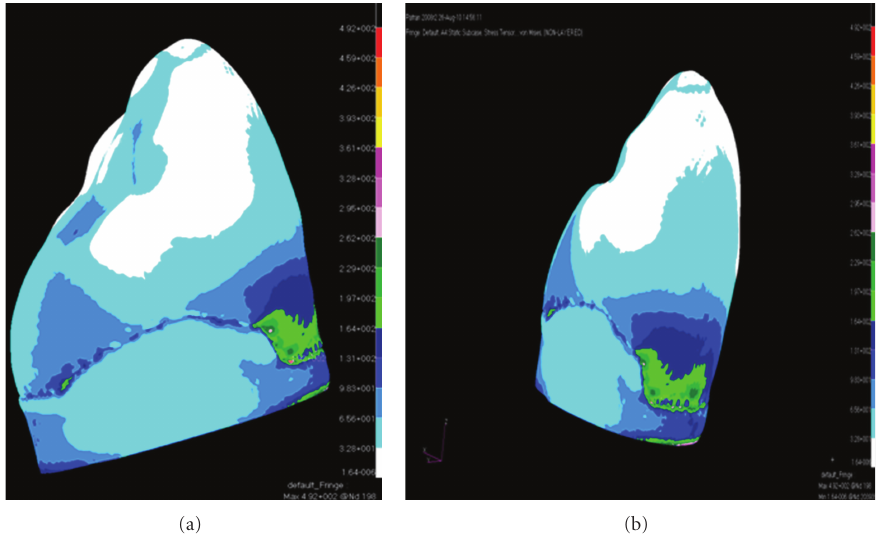
Figure 4: von Mises stress distribution caused by 200 N vertical and lateral load ((a) lateral view and (b) buccal